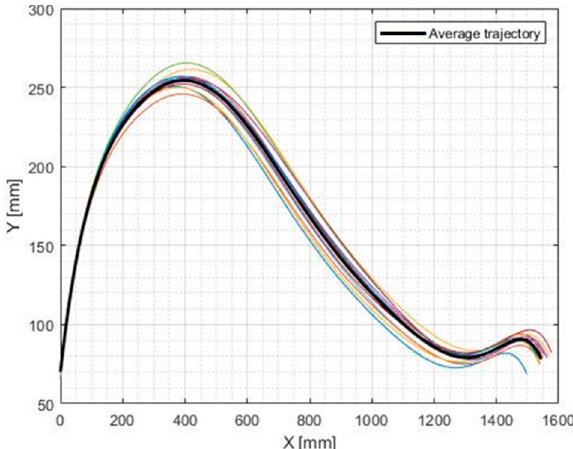
Figure 4. Ankle spatial trajectories ( n = 11) in the sagittal plane and related average trajectory of a 61 years old healthy subject walking at an average speed of 1.584 m/s. The initial position of each sampled path represents the position of the ankle at the instant of flat foot, preceding each swing phase. Each sampled path terminates at a variable ankle final position, recorded at the instant of heel strike.